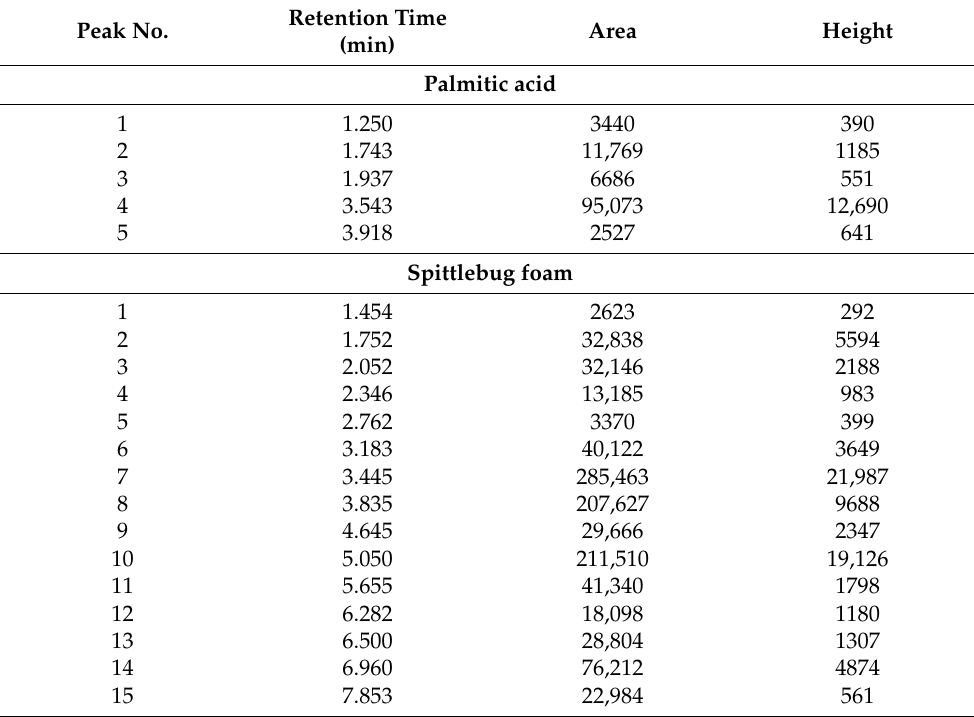
Figure 3. Fourier transform infrared spectroscopy spectrum of P. costalis foam. The HPLC spectra reveal the presence of many fatty acids in spittlebug foam with RTs ranging from 1.454 to 7.853 min (Table 7; Figure 4). Table 7. High-performance liquid chromatography (HPLC) analysis of palmitic acid and spittlebug P. costalis foam at 246 nm.